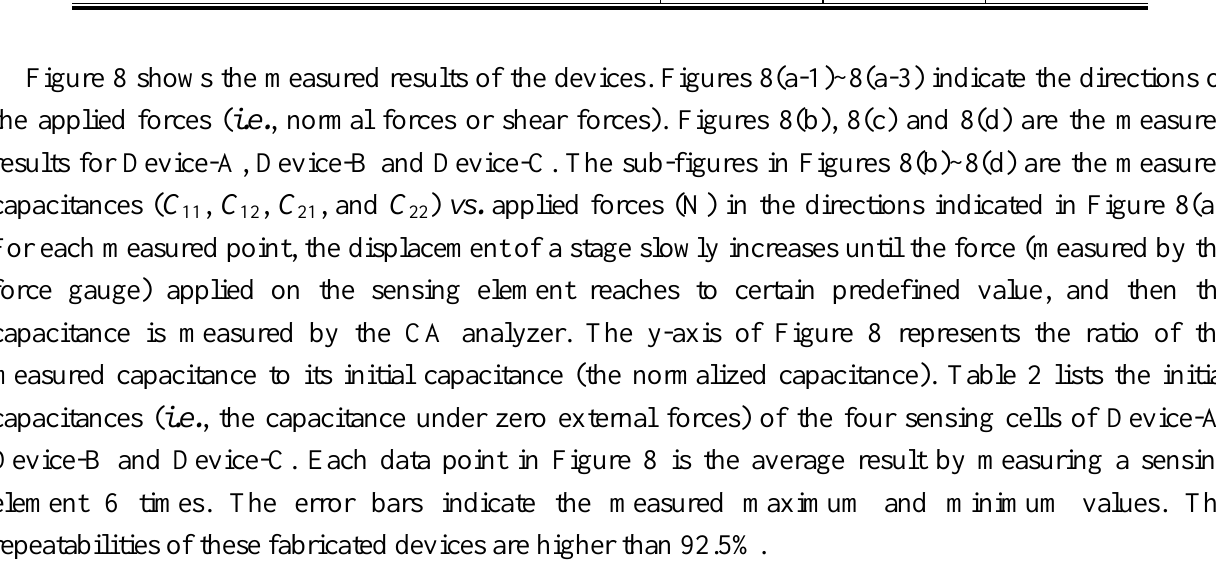
) of four capacitive sensing cells of Device-A, 0